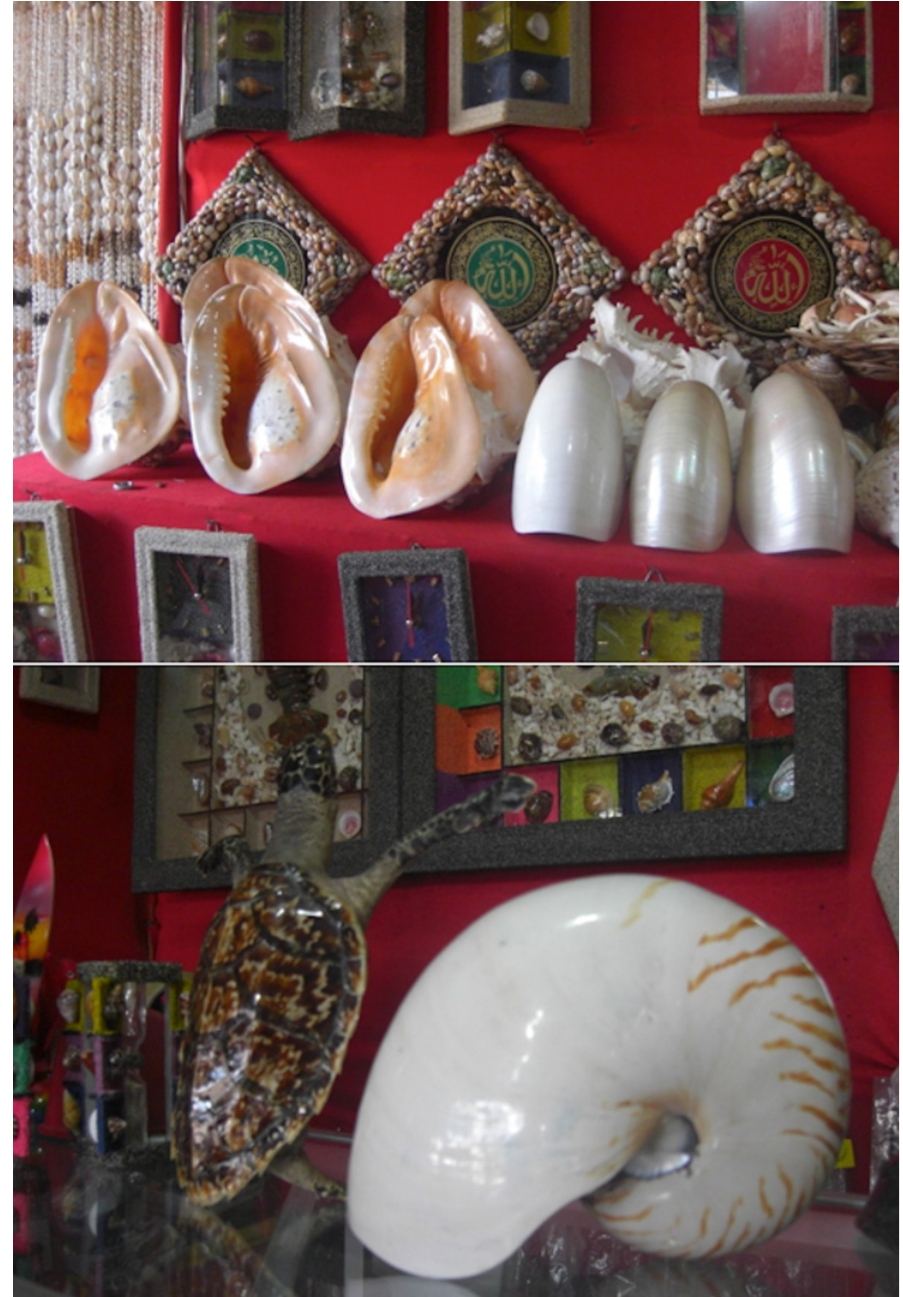
Fig 1. Legally protected shells for sale. Protected marine mollusc shells for sale in Pangandaran, Indonesia, June 2013. Top: Horned helmet Cassis cornuta and chambered nautilus Nautilus pompilius . Bottom: Chambered